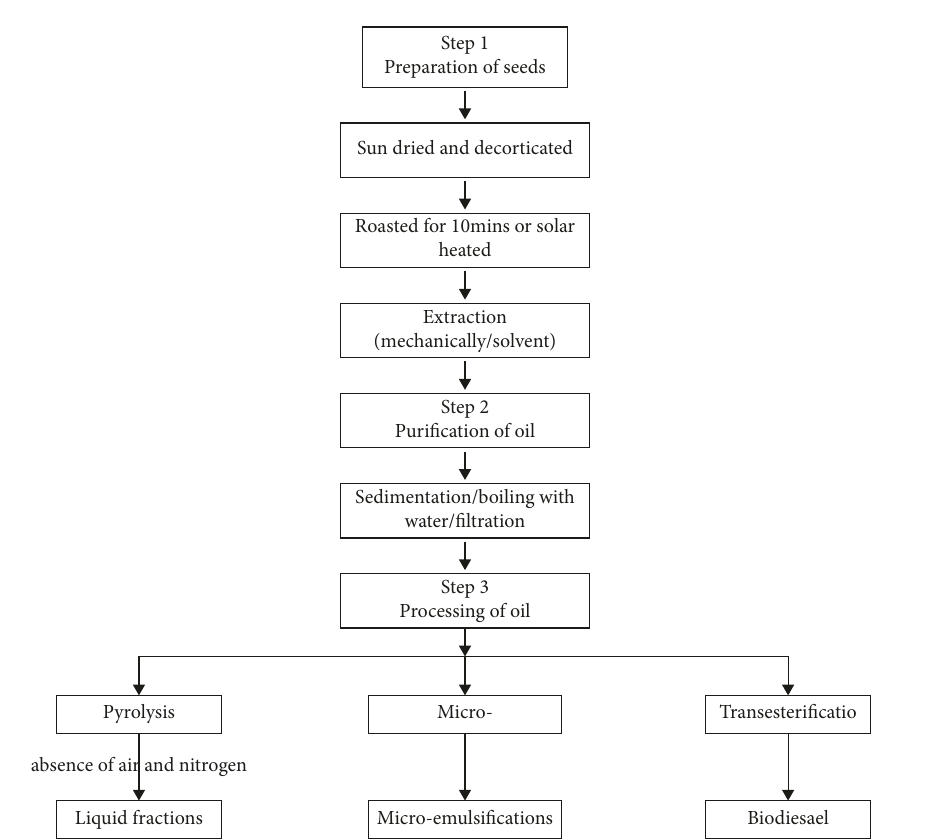
Figure 3: Process flow for a typical oil refining plant